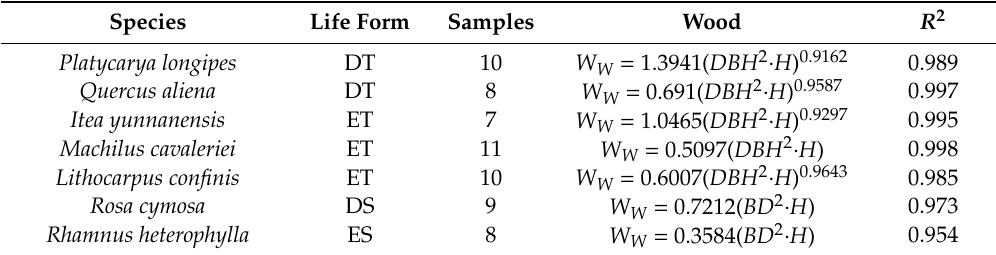
Table 3. Allometric regression equations (wood) for the most typical biomass in the karst study area, southwest China [21]. DT (Dedicous tree); ET (Evergreen tree); DS (Deciduous Shrub). W L , W W , DBH, BD, H are biomass of woody material (g), diameter at breast height (mm), basal diameter (mm) and height (m),